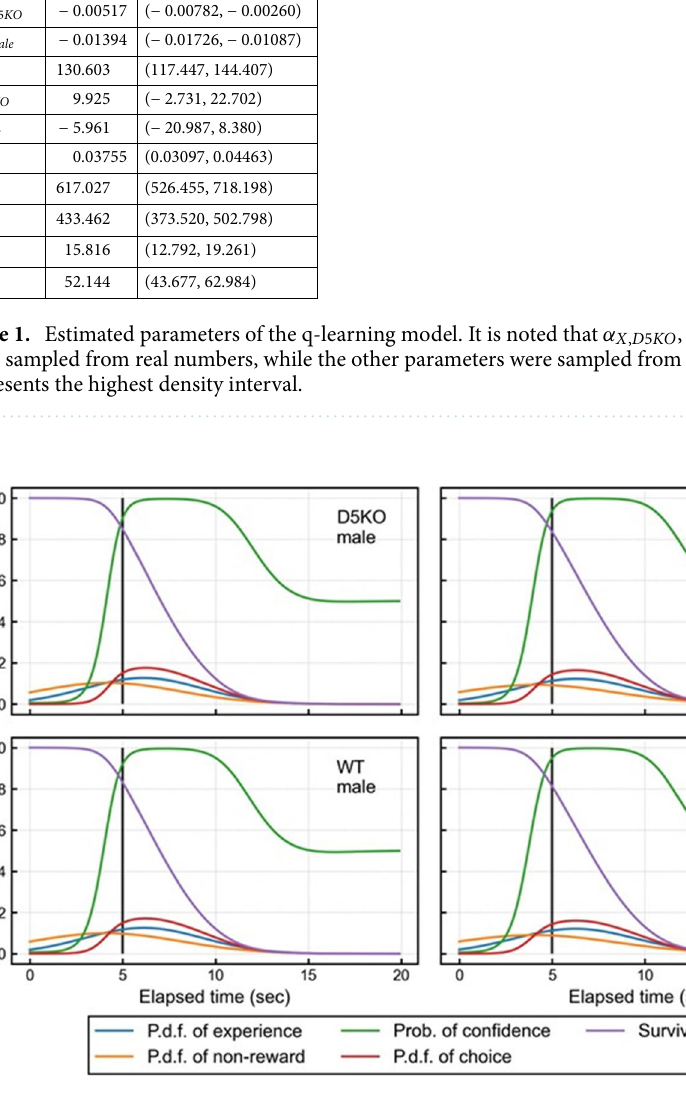
Figure 4. Averaged function values for the q-learning model at the end of the simulation with estimated parameters. Each simulation was run for 900 steps and 100 simulations were performed. Figure contains averaged values for these simulations at each elapsed time (s). The black line represents the flash timing of the trial. Each line represents the following: Probability density function (p.d.f.) of experience (blue); the p.d.f. of experience distribution. P.d.f. of non-reward (orange); the p.d.f. of non-reward distribution. Prob. of confidence (green); the probability of confidence at each elapsed time. P.d.f. of choice (red); the p.d.f. of choice distribution. Survival of choice (purple): the survival function of the choice